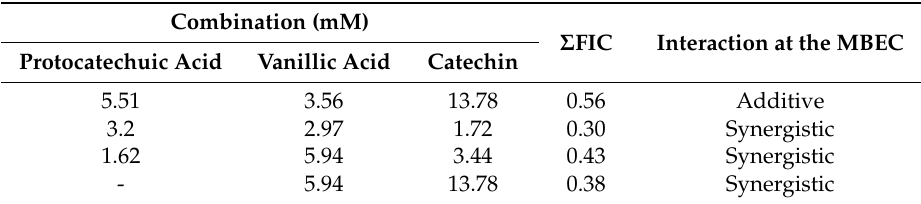
Figure 4. Viability of uropathogenic E. coli in pre-formed biofilms exposed during 1 h to phenolic compounds and nitrofurantoin. PA = protocatechuic acid, VA = vanillic acid, and Cat = catechin. Different letters indicate significant differences among treatments ( p ≤ 0.05). The means for three independent experiments ± deviation standard are illustrated in the table. * Mean values below the detection limit. Table 4. Combinations of phenolic compounds that eradicated uropathogenic E. coli in pre-formed biofilms on silicone surfaces for 24 h at 37 °C.